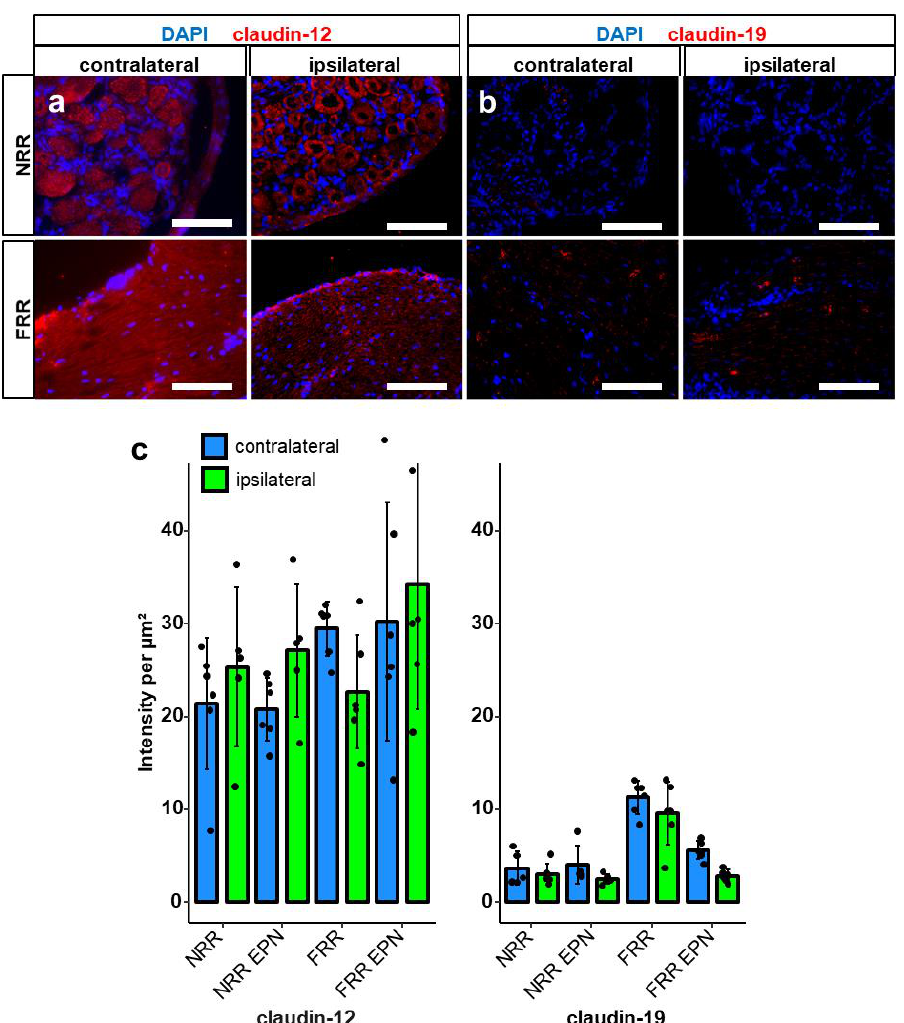
Figure 5. Claudin-19 and claudin-12-IR are unaltered after CCI. After CCI, DRG sections of Wistar rats were immunostained. IRs of claudin-12 and claudin-19 were quantified as light intensity per µm². and compared between IL and CL DRGs after CCI in the NRR and FRR, and their putative EPNs. Representative sections of claudin-12 (red) ( a ) and claudin-19 (red) ( b ) are shown. Quantification of the signal intensity in the specified areas: significant differences between regions are not indicated, as they were already analyzed in Figure 1 ( c ). (Scale bars = 100 µm. n = 5 or 6; claudin-19: FRR versus NRR, FRR versus NRR-EPN, and FRR versus FRR-EPN: p < 0.0001. No normal distribution: claudin-19 CL NRR-EPN. Two-way ANOVA, Tukey HSD).